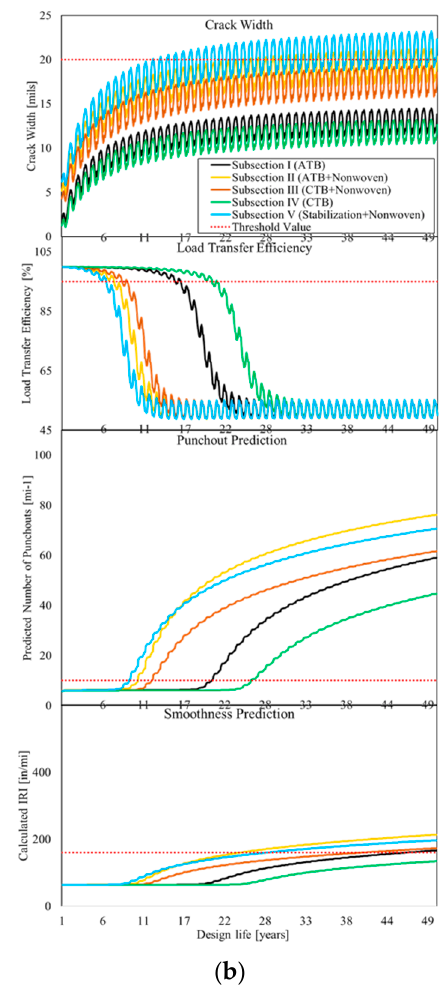
Figure 10. Variation of: CW, LTE, punchout prediction and smoothness prediction over time from MEPDG, ( a ): A5 Bruchsal, and ( b ): A5 Darmstadt.